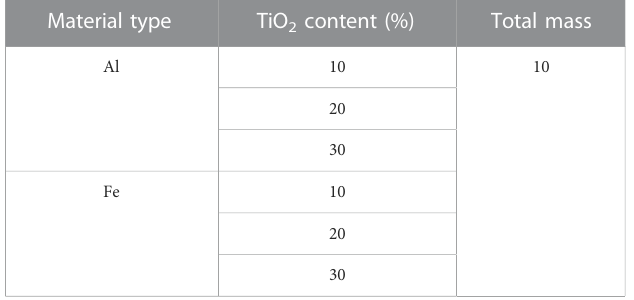
TABLE1Experimentalconditionsfortheignitionandcombustioncharacteristics. TABLE 2 Experimental conditions for the minimum ignition energy of iron